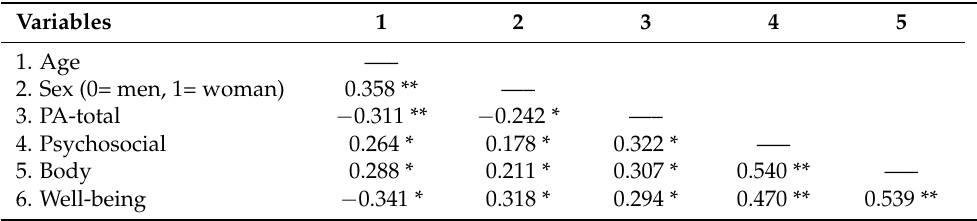
Table 2. Correlations between the key variables of the study.